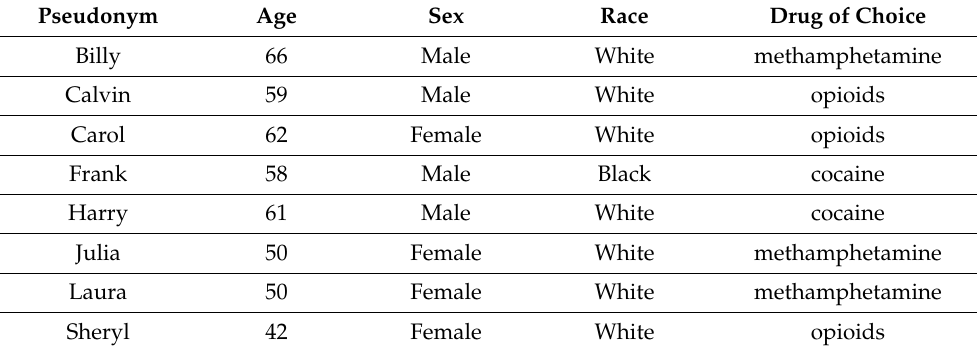
Table 3. Selected interviewee